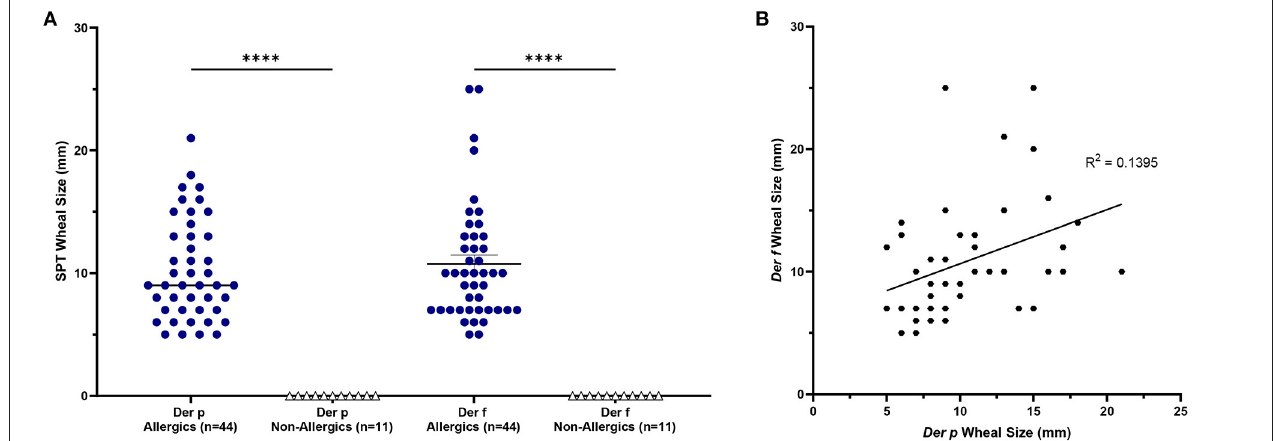
FIGURE 2 | SPT wheal sizes were significantly elevated for allergics. Allergics had significantly elevated SPT wheal sizes for both Der p and Der f compared to non-allergics (A) . A weak correlation (R 2 = 0.1395) was observed between wheal sizes of the two HDM allergens (B) . ****, p <